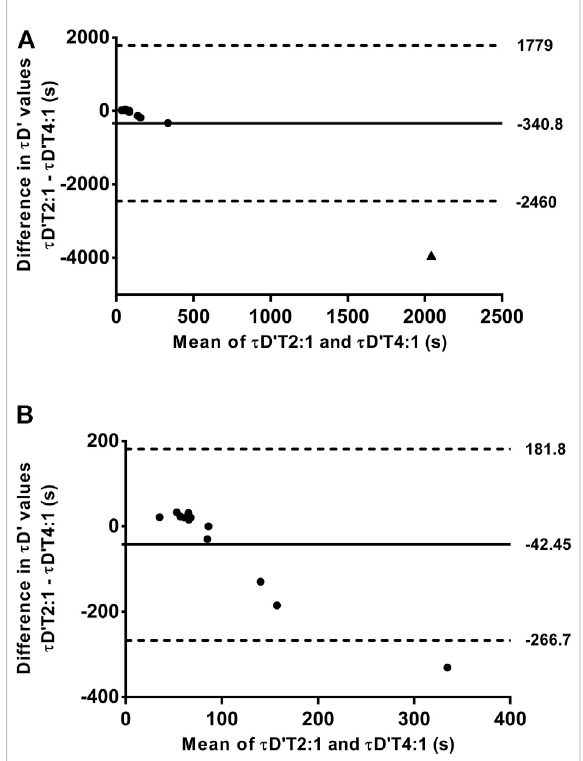
Bland — Altman plots between the time constant of the reconstitution of D ’ ( τ D ′ ) found by iterative process from training sessions with work/relief ratio of 2:1 (T2:1) and 4:1 (T4:1). The (A) included all swimmers while the (B) shows the data analyzed excluding the swimmer 11 (see results session for further details). Horizontal solid line represents the mean difference between τ D ′ found by iterative process from training sessions with work/relief ratioof2:1and4:1,whilehorizontaldashedlinesrepresentthe95% limit of agreement. ▲ represents the swimmer